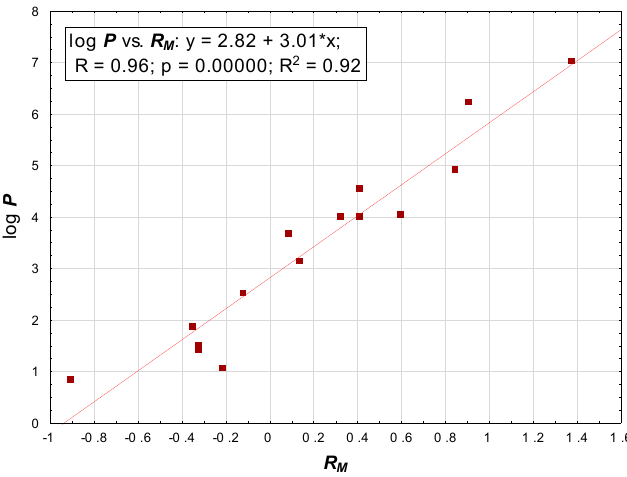
Figure 4. Correlation between calculated log P and R M .